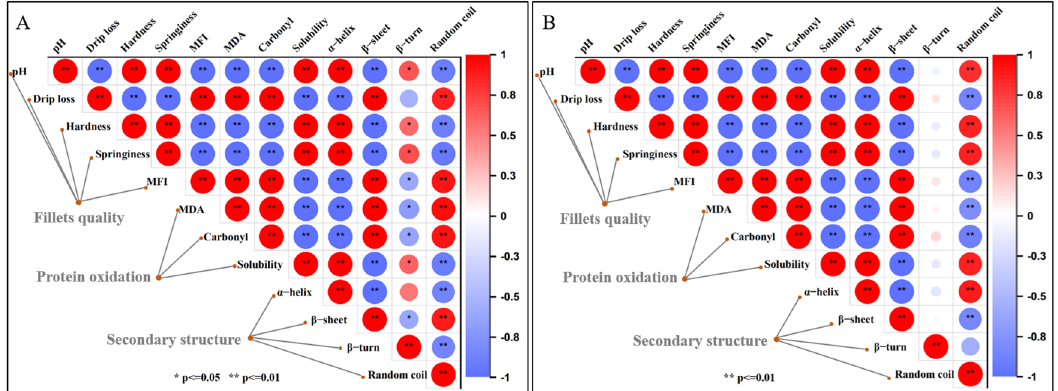
Figure 6. Clustering heatmap based on Pearson’s correlation tests between fillet quality, protein oxidation, and secondary structure of Coregonus peled under 4 °C refrigeration ( A ) and − 3 °C super chilling ( B ) storage. Darker red and darker blue indicate higher positive and negative correlations.